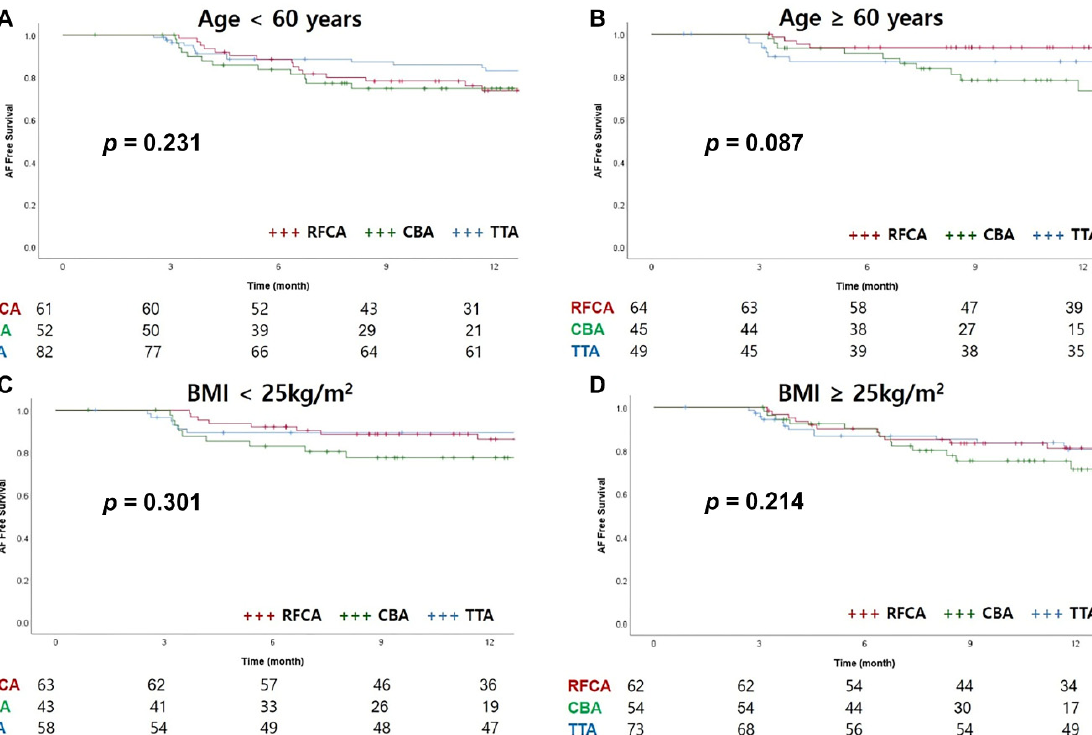
Table 3. The recurrence types of atrial tachyarrhythmias. Figure 3. Event ‐ free survival curves of the three groups. ( A ) AF ‐ free survival curve, ( B ) Arrhythmia ‐ free survival curve. Figure 3. Event-free survival curves of the three groups. ( A ) AF-free survival curve, ( B ) Arrhythmia-free survival curve. In the subgroup analysis of the AF-free survival rate, considering age, BMI, or LA diameter, there were no significant differences among the three groups (Figure 4). The AF-free survival rate in paroxysmal AF was significantly higher in the TTA group than in the other groups ( p = 0.008). However, in persistent AF, the CBA group tended to have a lower AF-free survival rate, but there was no statistically significant difference ( p = 0.315) (Figure 4G,H).